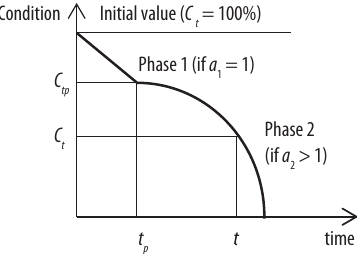
Fig. 2. Exemplary model of devaluation curve of a building element with two phases as a condition-time